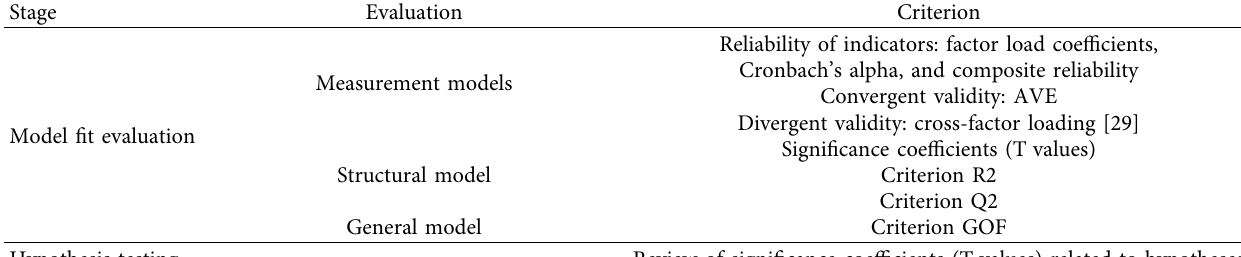
Table 4: Stages of testing hypotheses by structural equation modeling (SEM) using Smart PLS software.